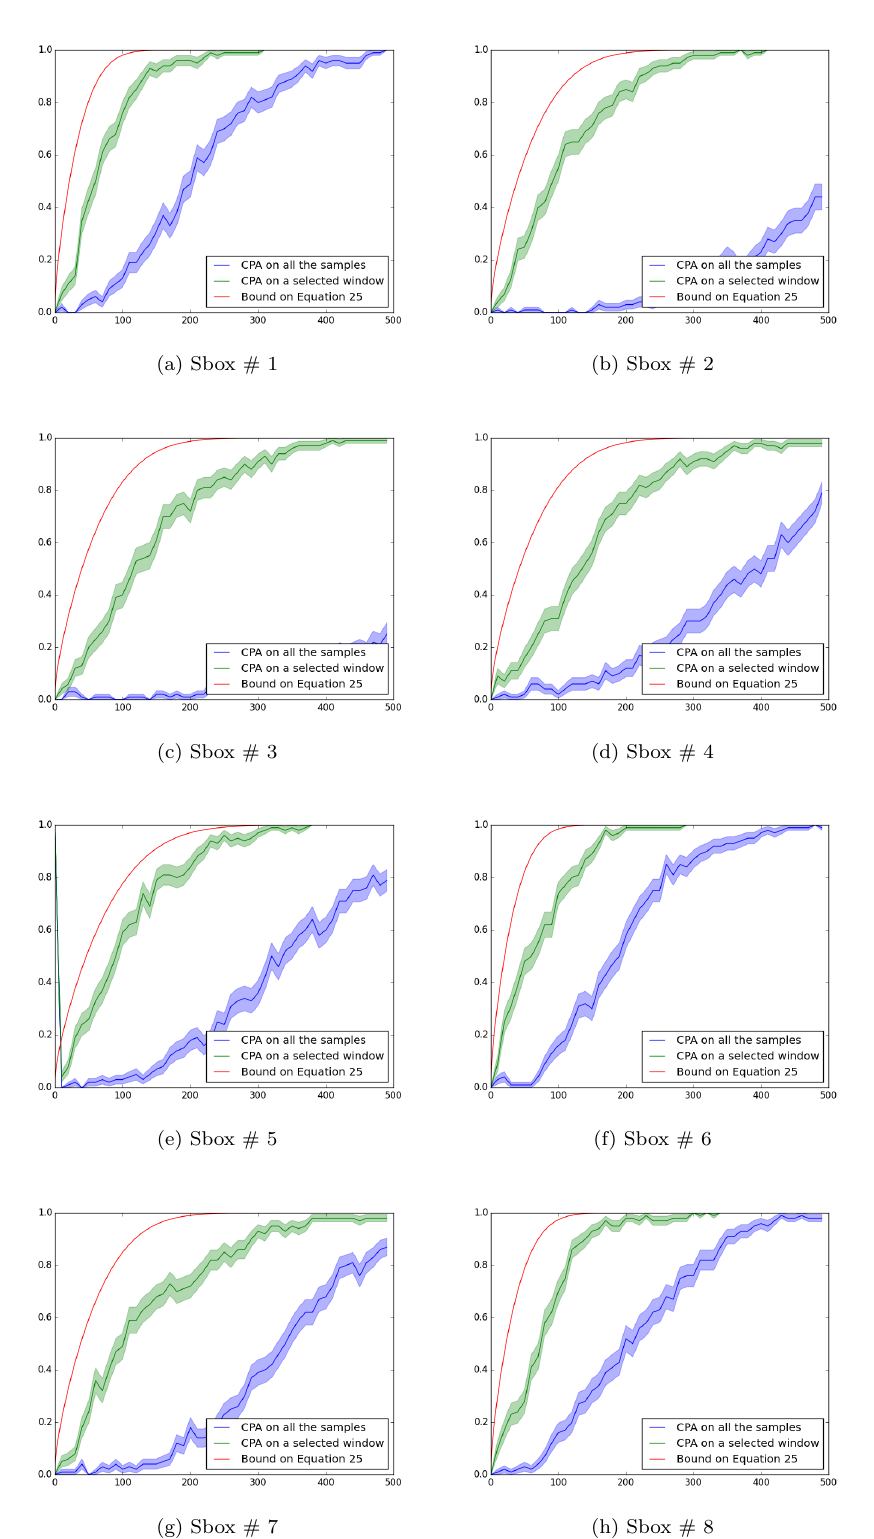
Figure 11: Success rates for CPA on the complete trace and on selected points of